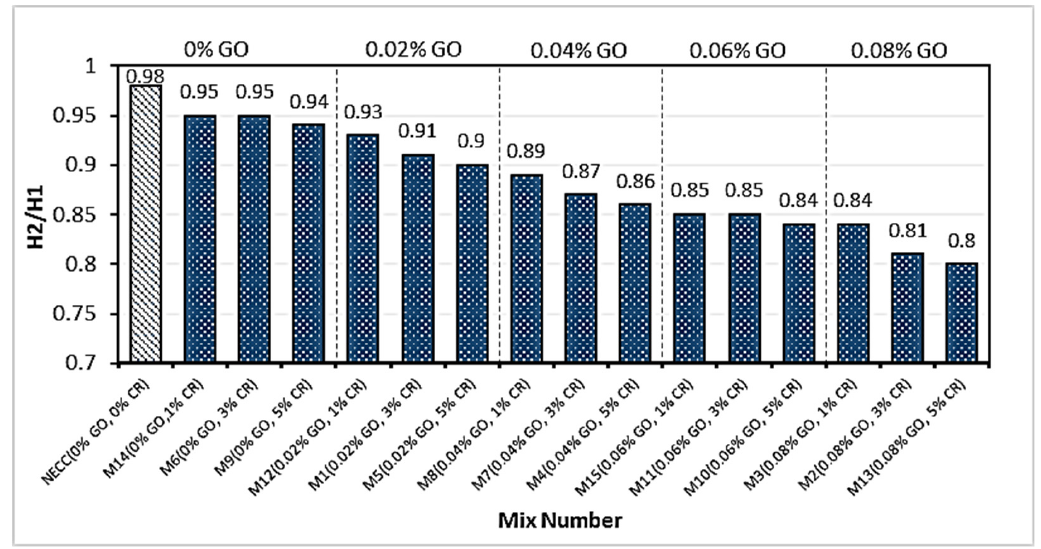
Figure 7. Blocking ratio (H2/H1).